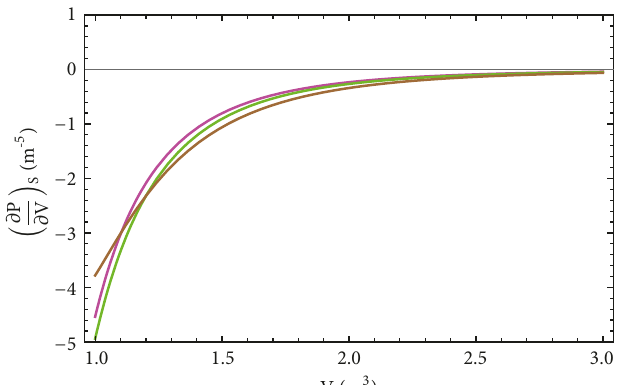
Figure 5: Plots of (𝜕𝑃/𝜕𝑉) 𝑆 versus 𝑉 for 𝛾 = −2, 𝐴 = 2,𝛼 = 0.1,𝑑 = 1 with 𝑍 = −15 (magenta), −7 (green), and −2 (brown).